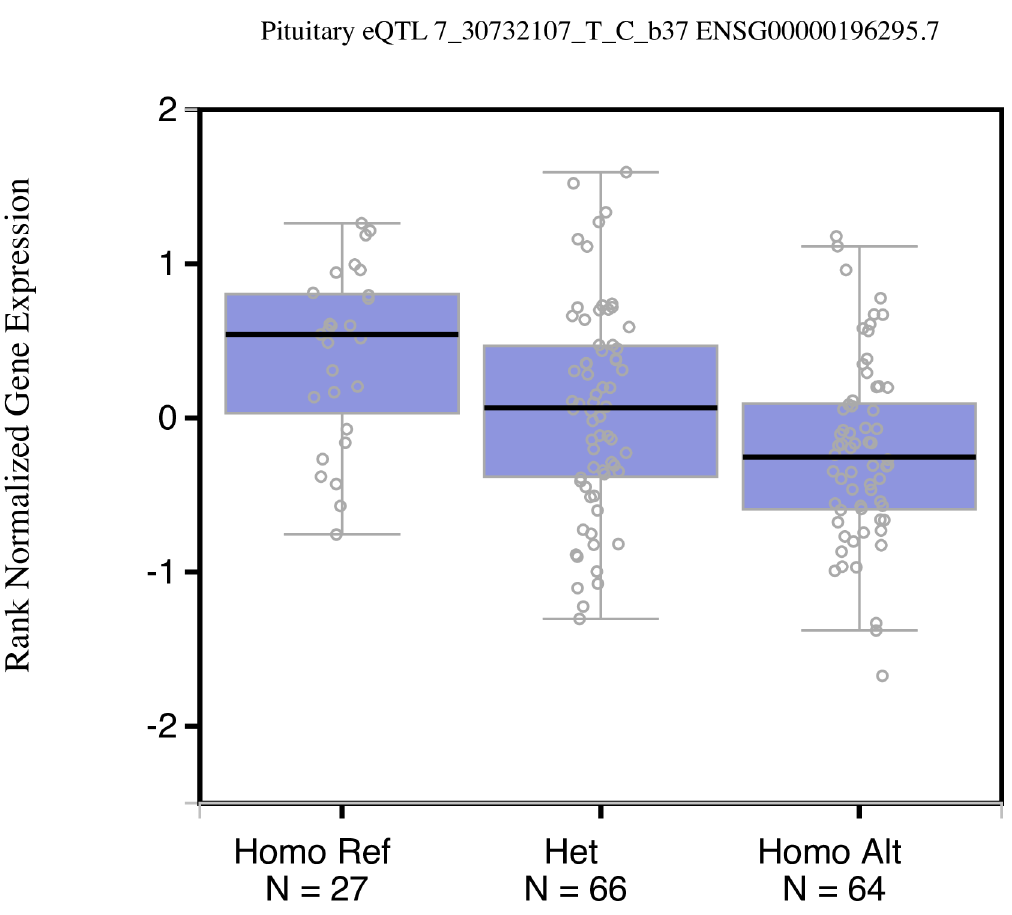
Fig 4. GTEx box plot showing relationships between SNP rs255015 (7_30732107_T_C_b37) genotype and lincRNA AC005154.6 (ENSG00000196295.7) expression in the pituitary ( P = 0.000008). The sample groups of the different genotypes are indicated on the X -axis; and the relative expression level of lincRNA AC005154.6 is shown on the Y -axis. The T allele (the reference allele and the ancestral minor allele in the EA population) leads to higher expression of lincRNA AC005154.6. Homo Ref: homozygote for the reference T allele, Het: heterozygote; Homo Alt: homozygote for the alternative allele.